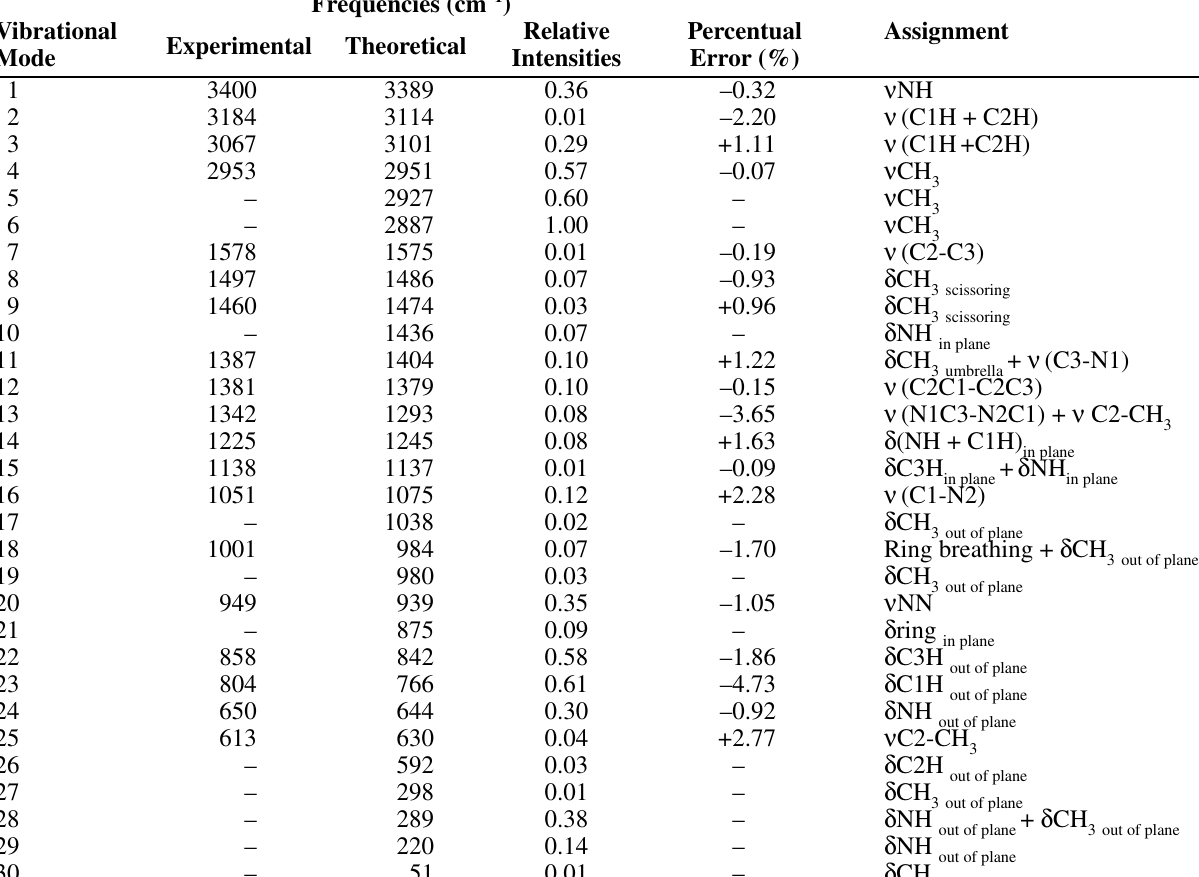
Table 2. Experimental and theoretical frequencies of 4-methylpyrazole (HmPz).